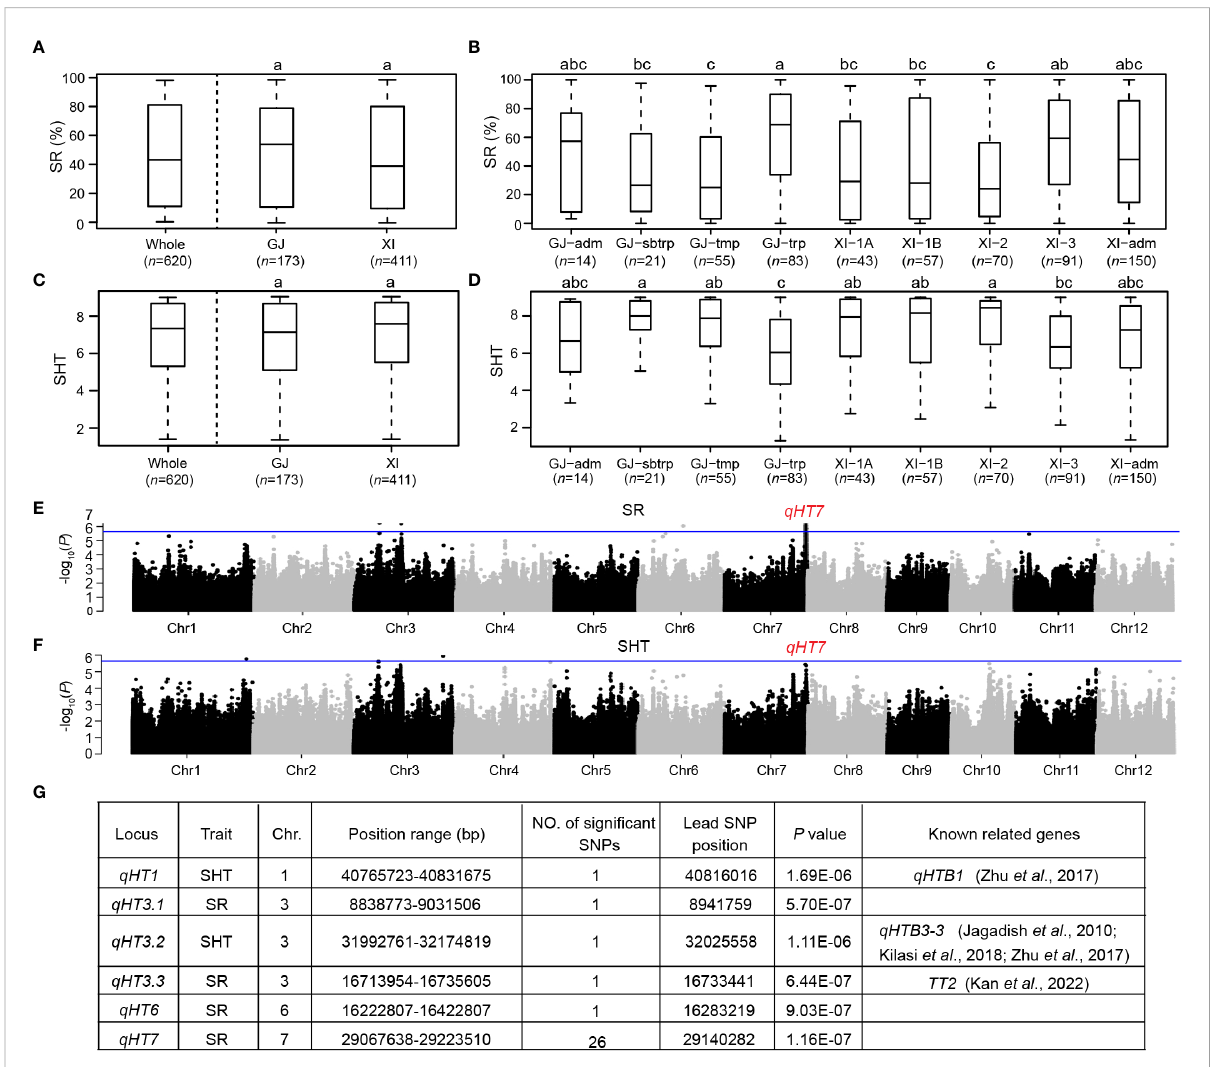
FIGURE 1 Phenotypic variations of heat tolerance and identi fi cation of loci associated with heat tolerance by GWAS in 620 rice accessions. (A) Box-plots of survival rate (SR) for the whole population, Xian / Indica ( XI ), and Geng / Japonica ( GJ ) subpopulations. (B) Box-plots of SR among GJ - adm , GJ - subtropical ( GJ-sbtrp ), GJ -temperate ( GJ-tmp ), GJ -tropical ( GJ-trp ), XI-1A , XI-1B , XI-2 , XI-3 , and XI-adm accessions. (C) Box-plots of leaf score of heat tolerance (SHT) for the whole population, XI and GJ subpopulations. (D) Box-plots of SHT among GJ - adm , GJ-sbtrp , GJ-tmp , GJ-trp , XI-1A , XI-1B , XI-2 , XI-3 , and XI-adm accessions. (E) Manhattan plots of GWAS results for SR. (F) Manhattan plots of GWAS results for SHT. (G) Genome-wide signi fi cant loci for SR and SHT. In A-D, different letters indicate signi fi cant differences ( P < 0.05, Duncan ’ s multiple range post- hoc test). In E, F, the horizontal blue lines represent the suggestive signi fi cant threshold ( P =